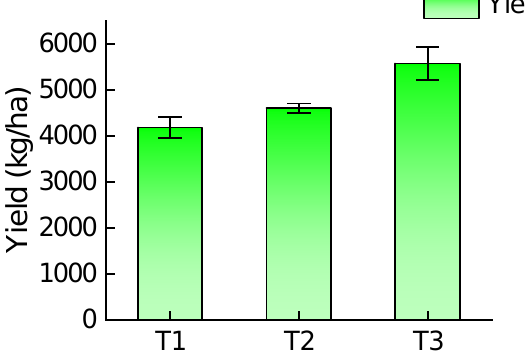
Figure 7. The comparison of winter wheat yield under different irrigation depth conditions.